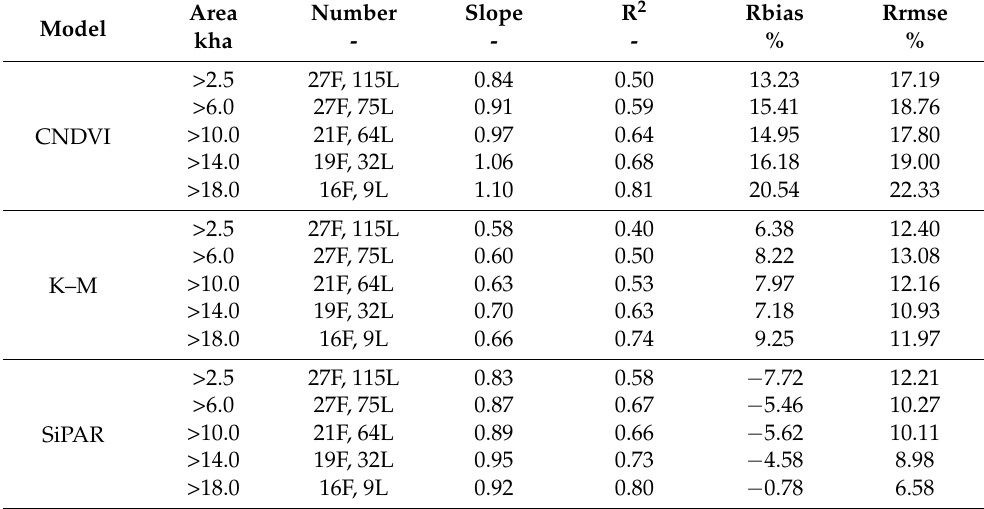
Figure 8. The predicted sugarcane yield against statistical data at the county level.